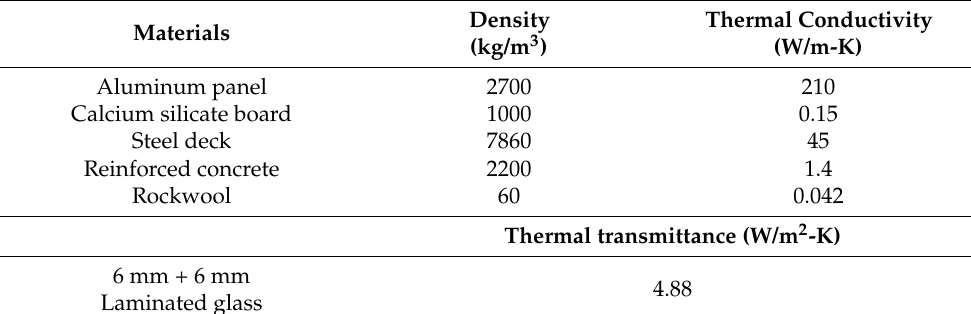
Table 2. Thermophysical properties of the materials.